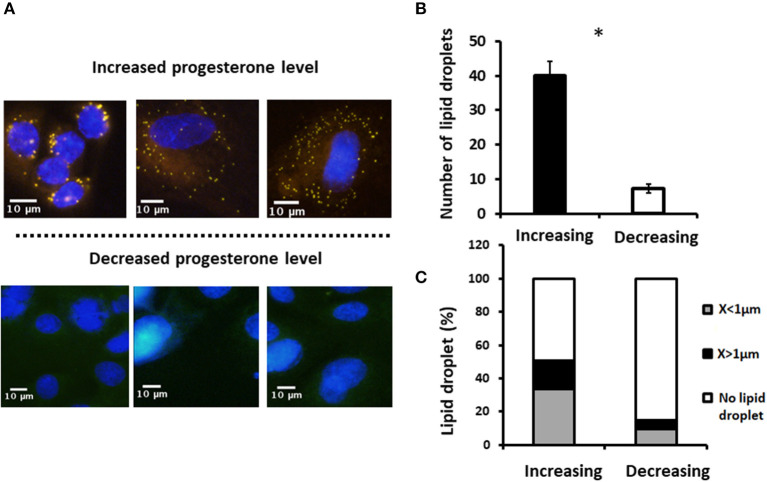
Incubation of mammary epithelial cells with increasing or decreasing progesterone concentrations changed the intracellular lipid droplet number and size. Mammary epithelial cells incubated with progesterone either in increasing (0.75, 2.5, and 5 ng/ml) or decreasing (5, 2.5, and 0.75 ng/ml) order. After incubation, nucleus was stained with DAPI (blue) and lipid droplets were stained with in Nile red (red) and their number and size recorded. (A) Representative figures from increasing and decreasing progesterone concentration treatments. Although at the end of the increasing treatment lipid droplets are easily visualized in the cytoplasm of the cells, no lipid droplets can be visualized after the decreasing treatment. (B) Number of lipid droplets after treatments with increasing or decreasing progesterone concentrations. Greater number of lipid droplets was counted in cells treated with increasing progesterone concentrations. (C) After treatment with increasing or decreasing progesterone concentrations, three phenotypes were examined: cells with large lipid droplets (x > 1 μm, black), cells with small lipid droplets (x < 1 μm, gray), and cells without lipid droplets (white). Cellular phenotype was designated according to the maximal diameter of its visualized lipid droplets. The large lipid droplet phenotype was only visualized in cells treated with increasing progesterone levels. Asterisk represents a significant difference between treatments at the level of p ≤ 0.0001.